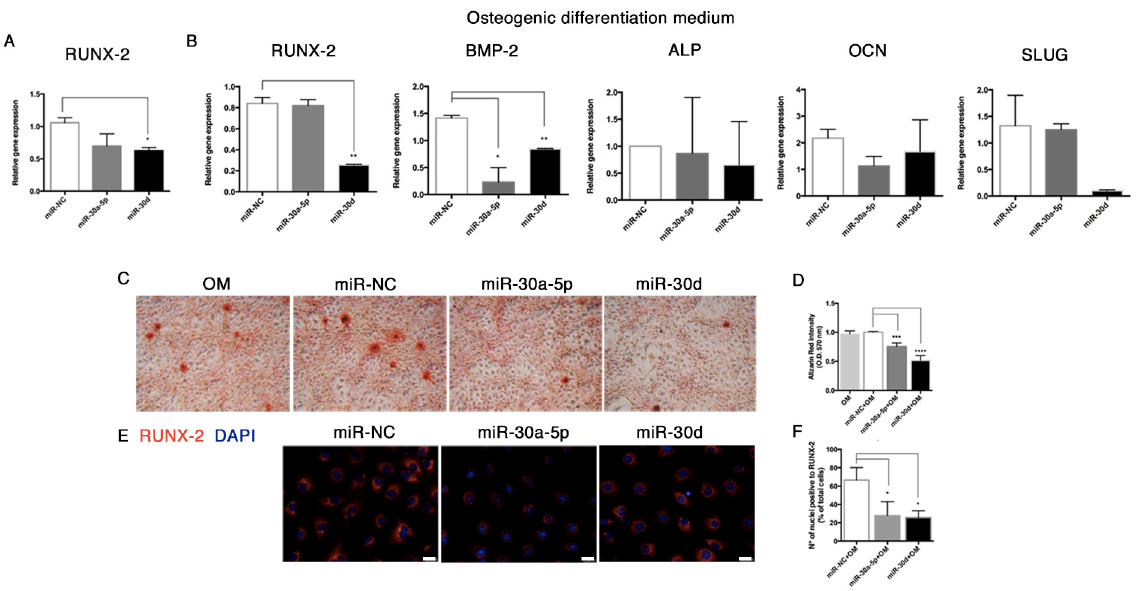
Figure 10. miR-30a-5p and miR-30d modulate the osteogenic differentiation potential in HUVECs. ( A ) RUNX-2 relative expression in HUVECs at 48 h post-miRNA transfections. ( B ) Gene expression analysis (RUNX-2, BMP-2, ALP, OCN, SLUG) in HUVECs after miRNA over-expression during 14-day exposure to osteogenic induction medium. ( C ) Alizarin red stain of HUVECs after miRNA over-expression during osteogenic induction for 14 days, and ( D ) relative quantification, performed by reading the absorbance at O.D. 570 nm by spectrophotometer. Images are representative of at least three independent experiments (40 × magnification). Results were normalized to control cells cultured in DMEM. ( E ) Immunofluorescence of RUNX-2 in HUVECs after miRNA over-expression during osteogenic induction for 14 days, and ( F ) relative quantification expressed as percentage of positive nuclei on total cell number. Scale bars = 25 µ m. OM: osteogenic medium. All data are expressed as mean ± SD of 4 independent experiments, and statistical analysis was performed between miRNA-mimic transfected cells and miR-NC group, by unpaired Student’s t -test. *, p < 0.05; **, p < 0.01; ***, p < 0.001; ****, p < 0.0001. BMP-2, bone morphogenetic protein-2; ALP, alkaline phosphatase; OCN, osteocalcin.